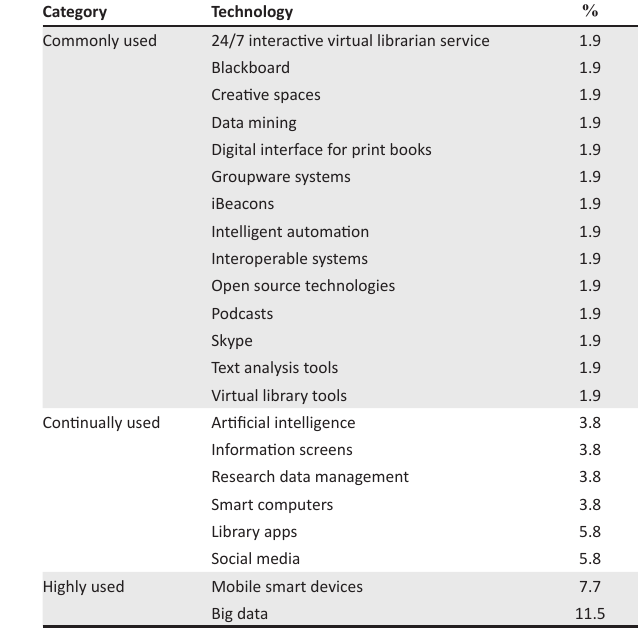
TABLE 2: Technologies associated with knowledge creation and sharing (own source).